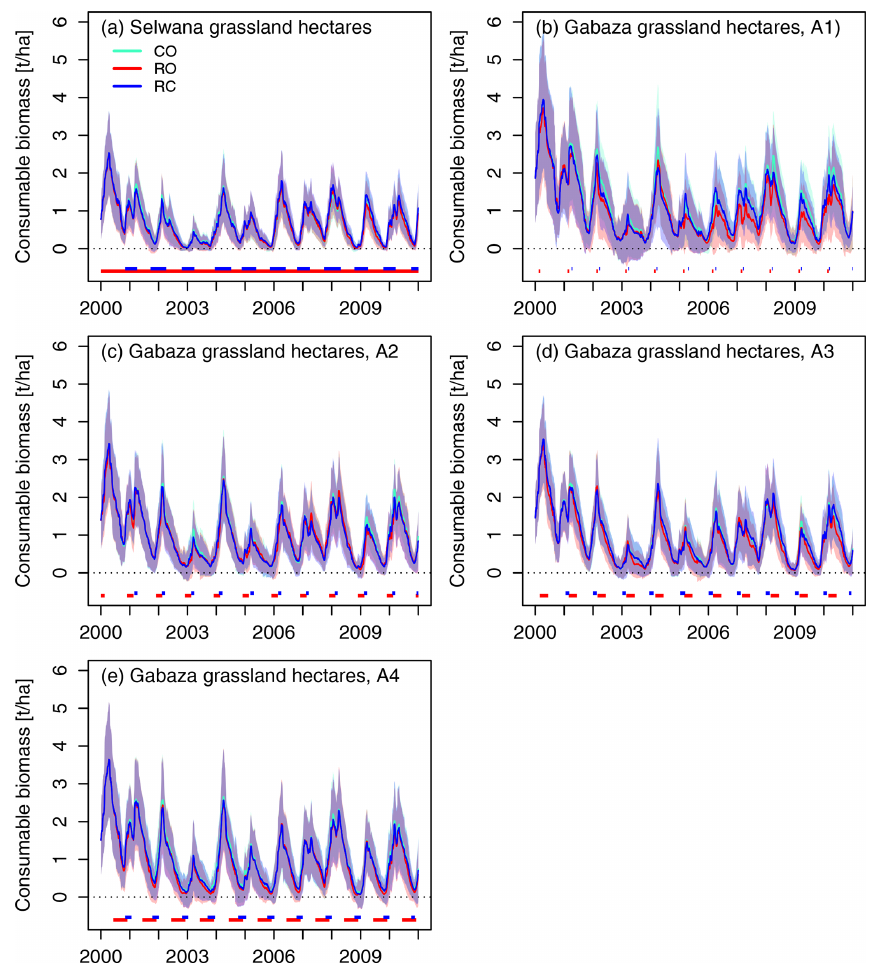
Figure 10. Temporal dynamics of average consumable grass biomass on simulated grassland hectares (living and dead standing grass leaf biomass, and reproductive biomass, reduced by the minimum amount that is not available to grazers, i.e., 0.3th − 1 for living and dead grass biomass, respectively, and 0.1tha − 1 of reproductive biomass). Lines denote the mean across all simulated hectares, and shaded areas show the standard deviation. The horizontal lines at the bottom of the panels denote the respective animal presence times for the RO and RC